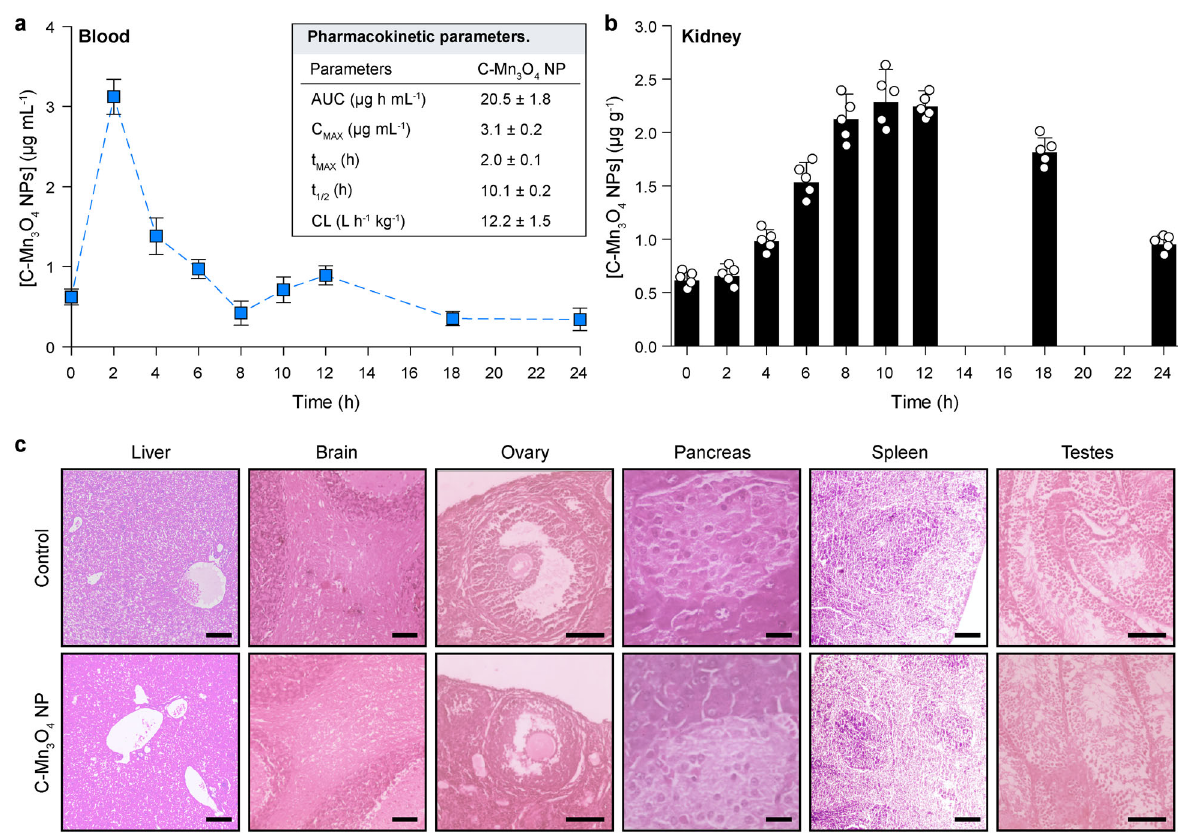
Fig. 7 Pharmacokinetics (PK) and biocompatibility of C-Mn 3 O 4 NPs. a Plasma concentration-time pro fi le following intraperitoneal administration of C-Mn 3 O 4 NPs as measured using inductively coupled plasma-atomic emission spectroscopy (ICP-AES). Inset shows the PK parameters calculated using a non-compartmental approach. The dotted line is a guide to the eye. b Time-dependent accumulation and elimination of C-Mn 3 O 4 NPs in the kidney. Data were normalized to wet kidney weight. c Micrographs of hematoxylin and eosin-stained sections of different organs after 1 month of treatment with the therapeutic dose (0.25 mg kg − 1 body weight, i.p.) of C-Mn 3 O 4 NPs. Both control and treated animals maintained normal tissue architecture. Scale bars: liver-100 µ m, brain-50 µ m, ovary-20 µ m, pancreas-50 µ m, spleen-100 µ m, testes-100 µ m. Data were expressed as Mean± SD. Individual data points are represented as white circles ( N =